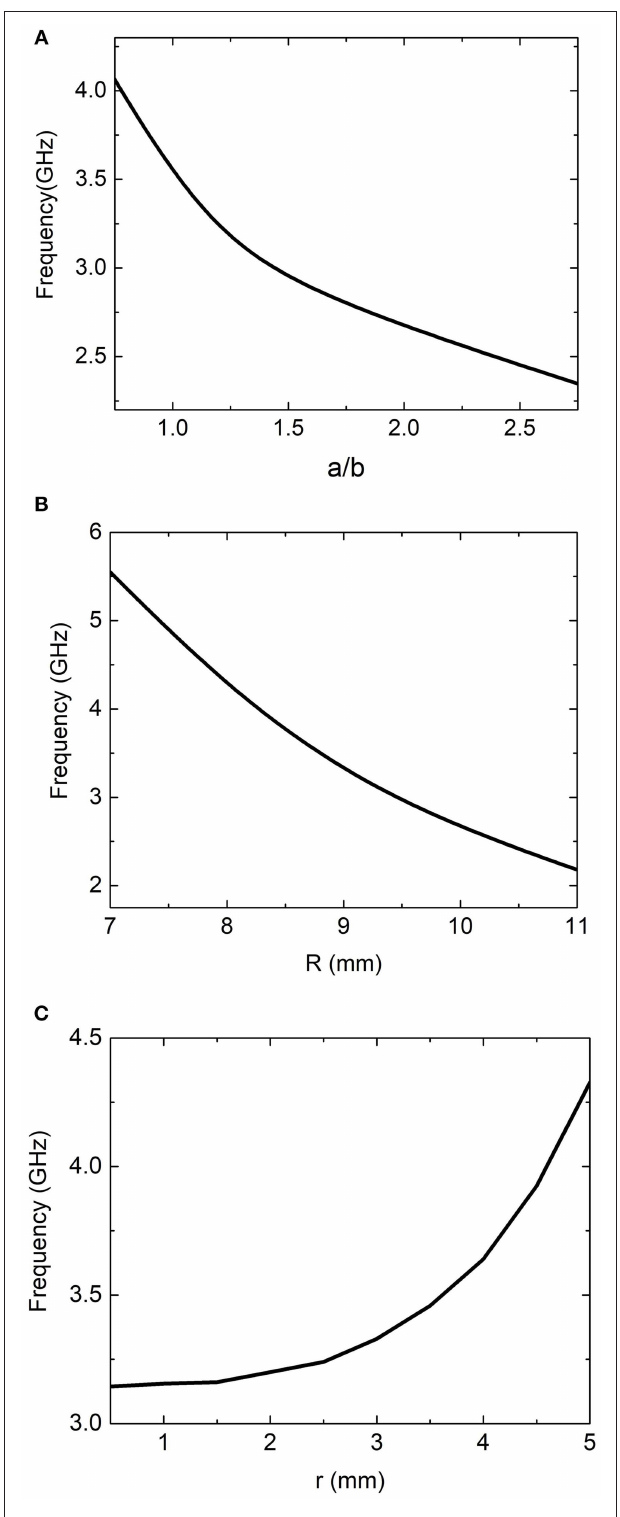
FIGURE 2 | The resonance frequencies of spoof magnetic plasmon modes as a function of the filling factor a/b (A) , outer radius R (B) and inner radius r (C) .